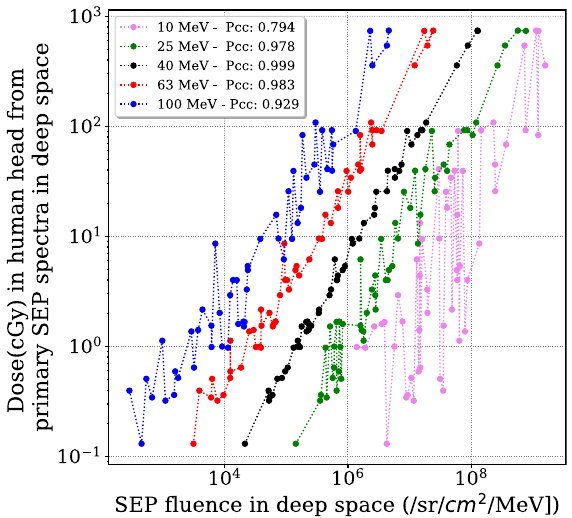
Figure 4. Dose (cGy) deposit in the human head, with 2 mm of shielding around, induced by each SEP event under study versus the original SEP fluence at a few specific energies as marked in different colors and labeled in the legend with the Pearson correlation coefficients (Pcc) for different